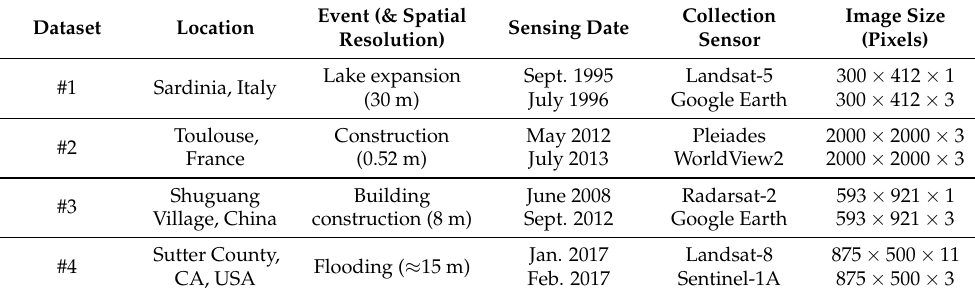
Table 1. Description of the four heterogeneous data